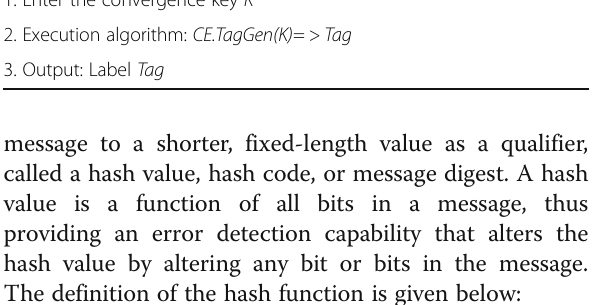
Table 4 Algorithm of generation tag Algorithm 4: Tag generation algorithm